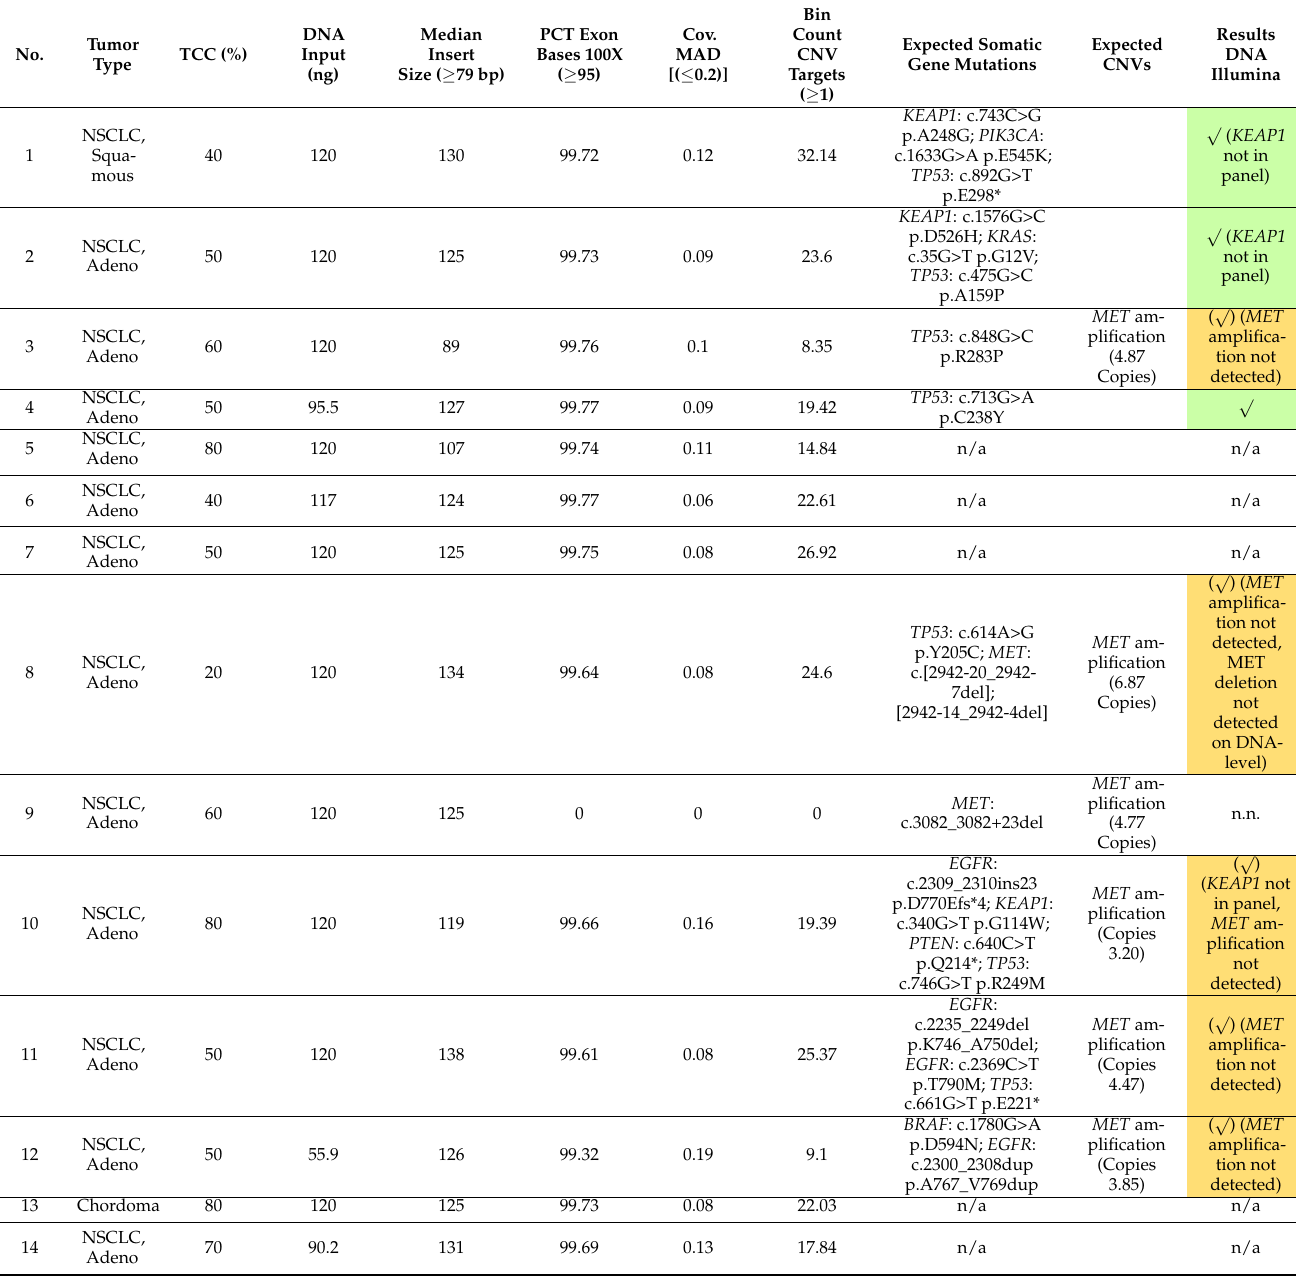
Table 1. Results and quality scores of the 44 DNA samples analyzed with the TruSight Tumor 170